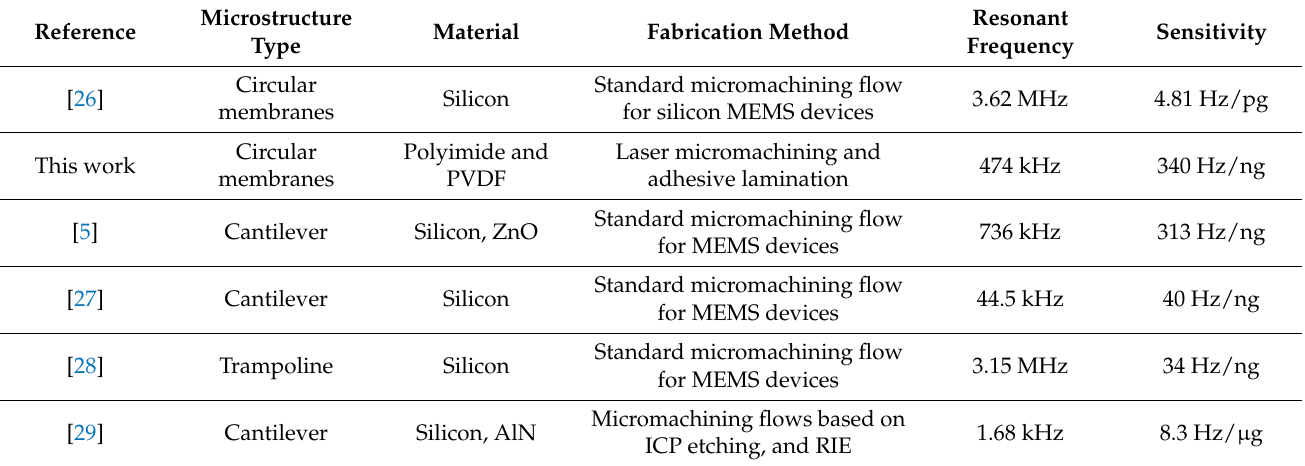
Table 6. Comparison of mass sensor